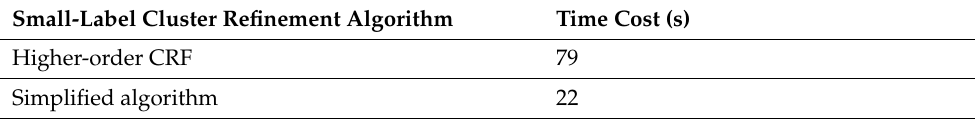
Table 13. Time cost of the small-label cluster refinement process with different algorithms.